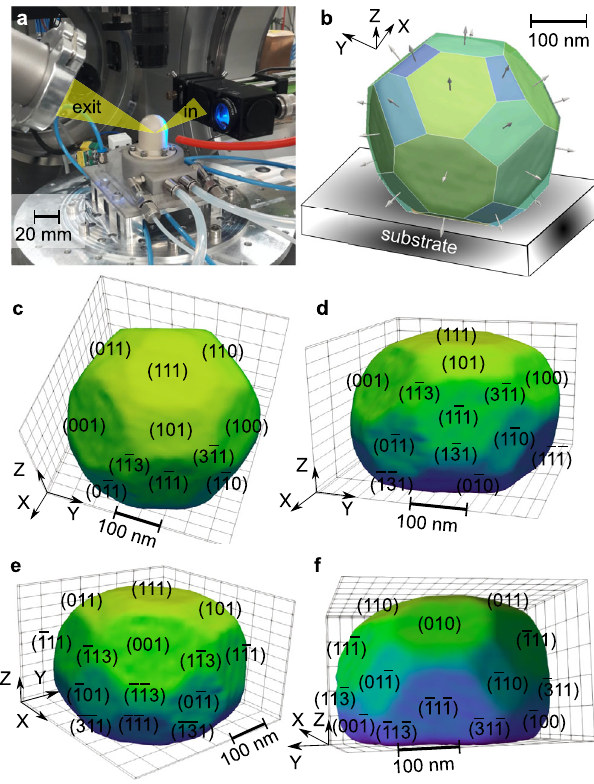
Fig. 1 Experimental set-up and morphology of Pt nanocrystal. a Photograph of the experimental set-up with the gas reactor at the P10 beamline of the PETRA III synchrotron. b – f Different views of the BCDI reconstruction (drawn at 50% of the maximum Bragg electron density) of NP300. The different facets are indexed by their Miller ( hkl ) indices. The colour coding in Fig. b varies as a function of the facet size. The colour coding in Fig. c – f varies with the value of the normal of the facets. The position of the substrate with respect to the NP is shown in b , showing the [1 1 1] out-of-plane orientation of the Pt